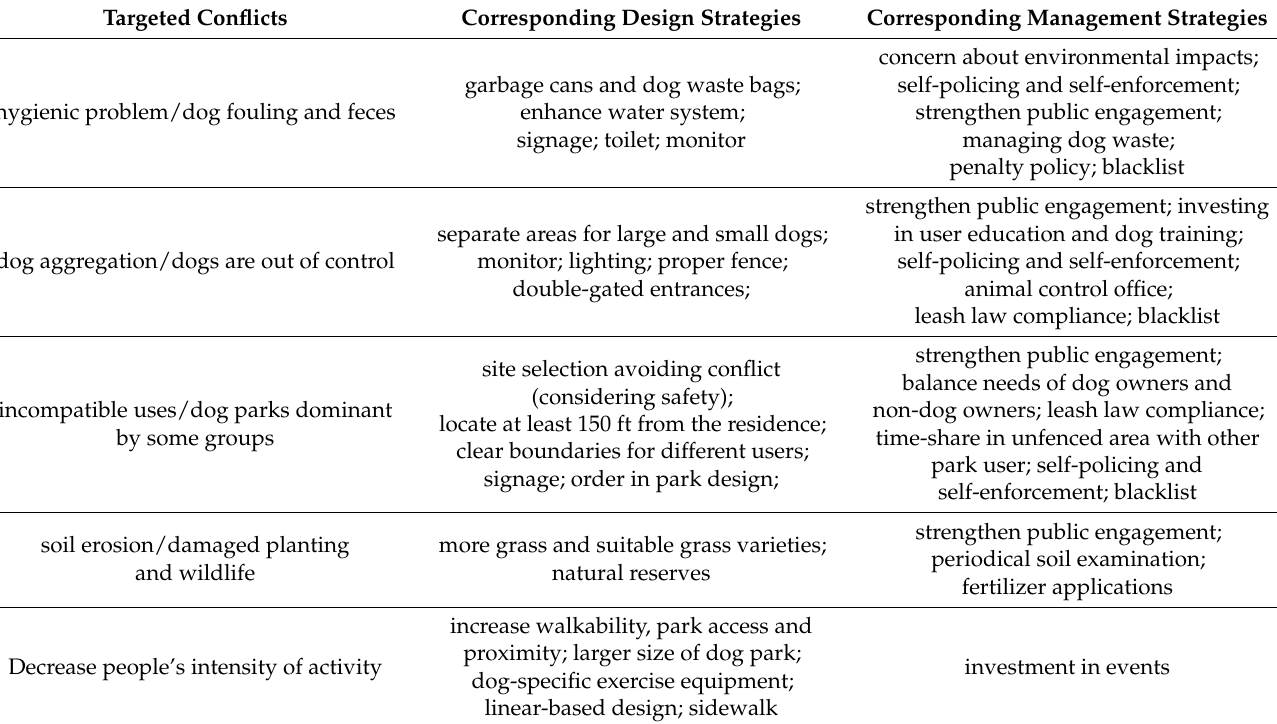
Table 3. Targeted conflicts and their corresponding design and management strategies for dog